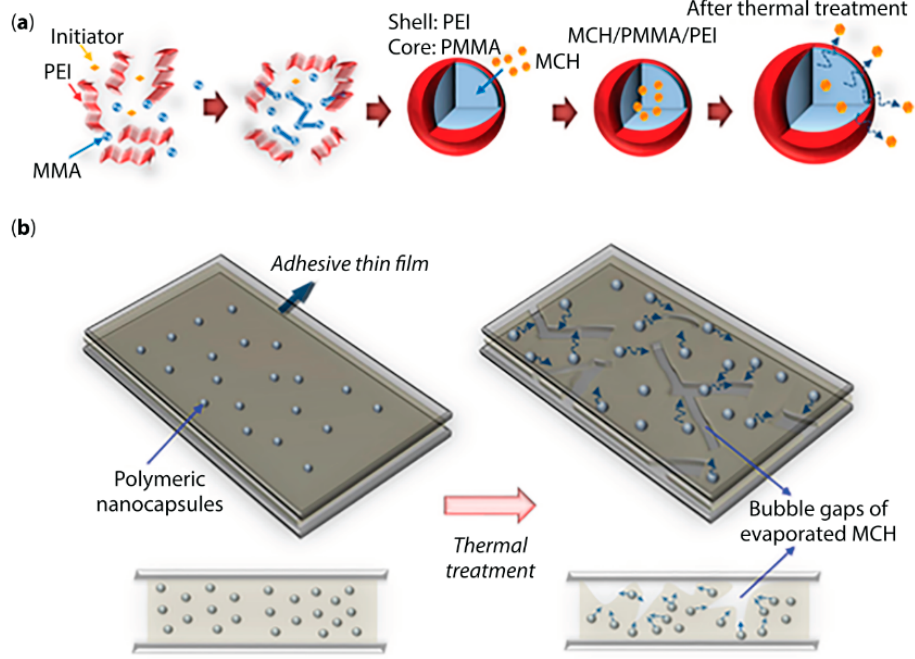
Figure 11. Debonding technique using polymeric nanocapsules with an adhesive thin film, which forms gas bubbles through thermal stimulus. ( a ) Synthesis concept of a polymeric nanocapsule containing internal vaporizing material, namely nanocapsules composed by hydrophobic methylcyclohexane (MCH) / poly(methyl methacrylate (PMMA) in the core and polyethyleneimine (PEI) in the shell. ( b ) Schematic representation of debonding mechanism through the formation of bubble gaps at the interface of a thin film adhesive, by heating the adhesive system [196]. Reprinted from Journal of Applied Polymer Science, Vol. 135, Issue 31, Lee et al. “Polymeric nanocapsules containing methylcyclohexane for improving thermally induced debonding of thin adhesive films”, Pages No.